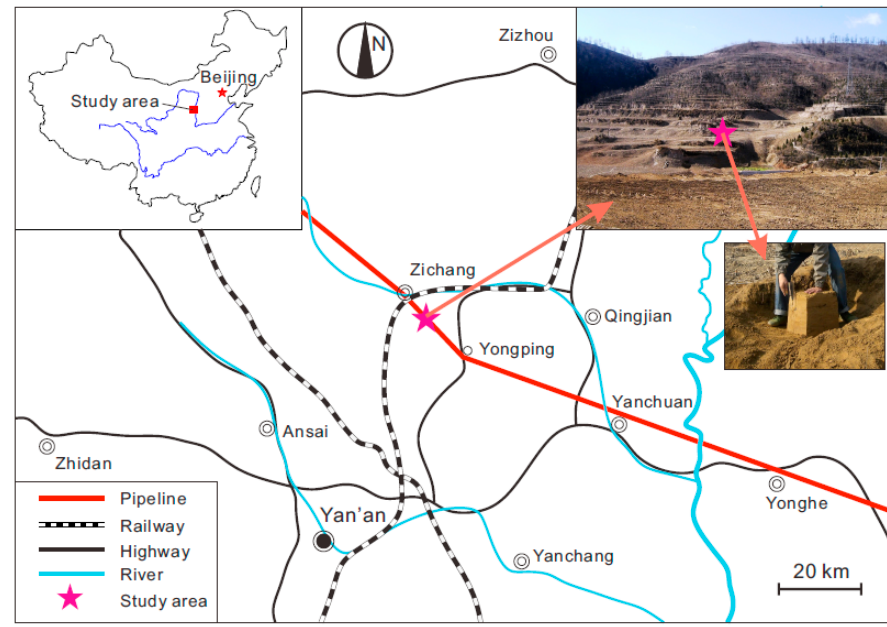
Figure 1. Location and photos of sampling area.